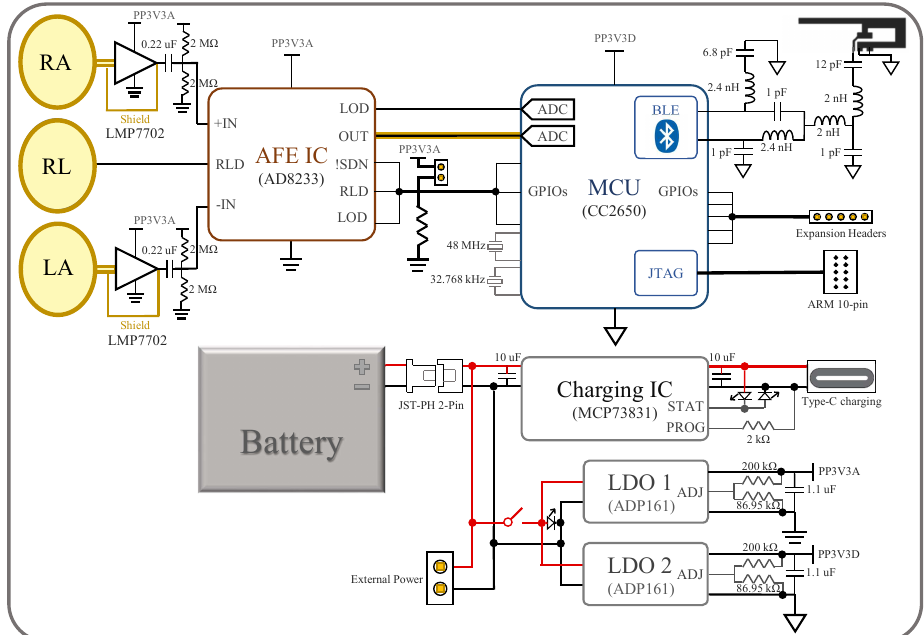
Figure 2. Overall block diagram of the